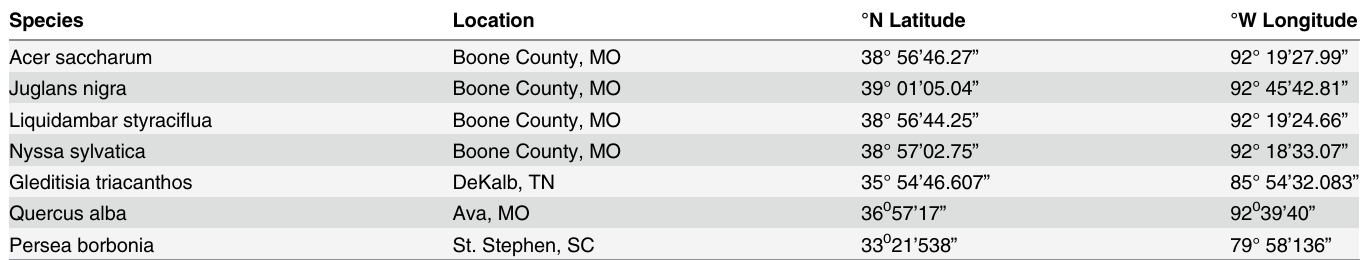
Table 1. Coordinates for sampled